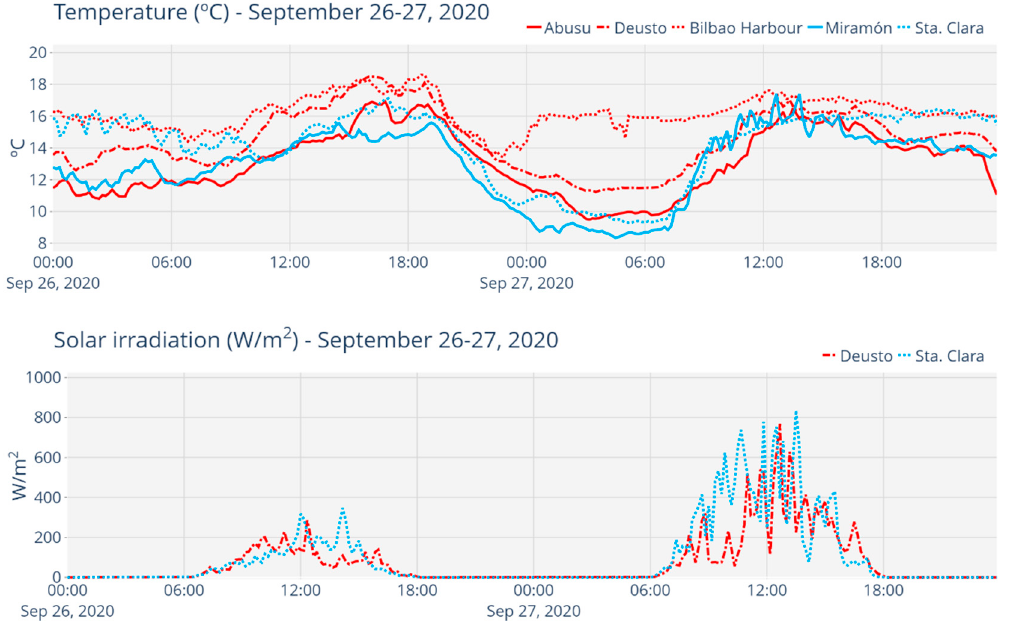
Figure 15. Comparison between temperatures recorded and solar radiation recorded on a cloudy day followed by a clear day in September (26–27 September 2020). Source: authors.